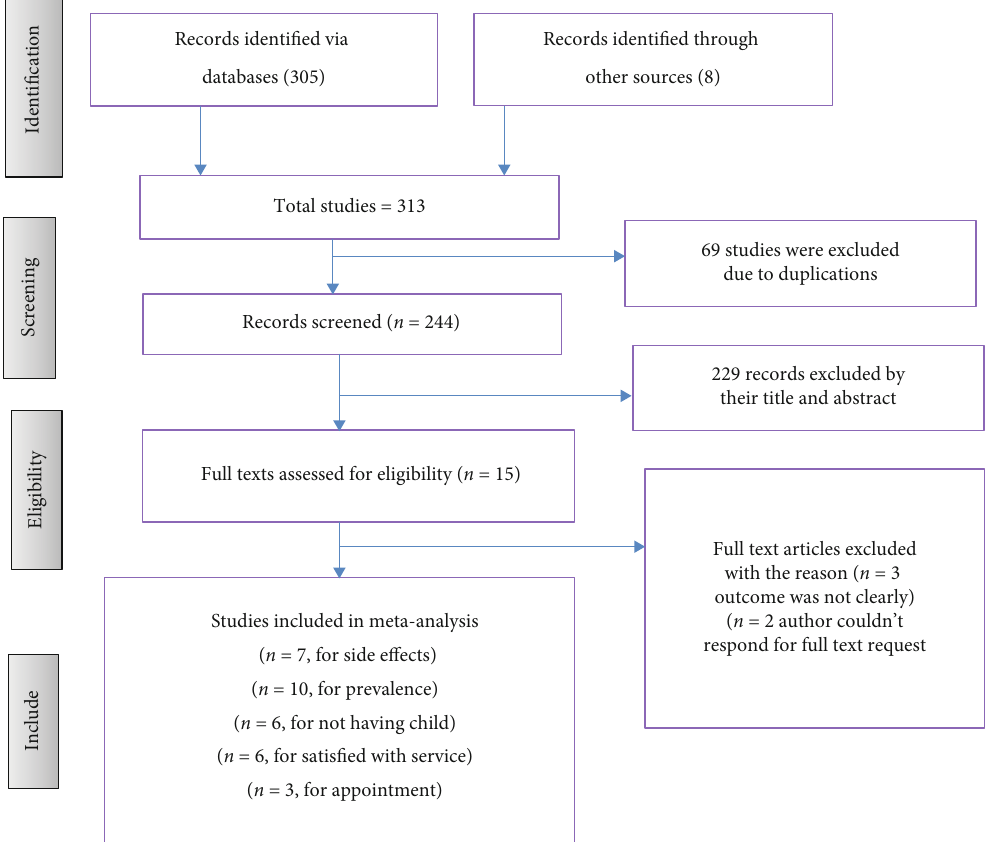
Figure 1: PRISMA fl ow diagram of the included studies for meta-analysis of prevalence of Implanon discontinuation among reproductive age women in Ethiopia,